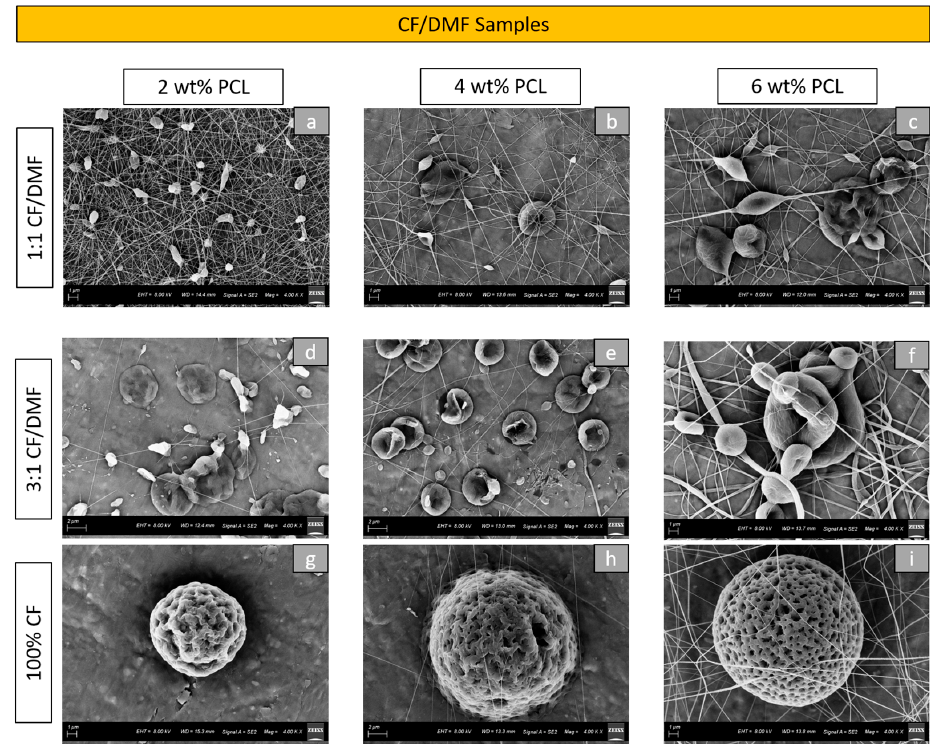
Figure 1. High magnification (4.00 kx) SEM images of PCL particles created by electrospraying: ( a ) 2 wt% PCL with 1:1 CF/DMF; ( b ) 4 wt% PCL with 1:1 CF/DMF; ( c ) 6 wt% PCL with 1:1 CF/DMF; ( d ) 2 wt% PCL with 3:1 CF/DMF; ( e ) 4 wt% PCL with 3:1 CF/DMF; ( f ) 6 wt% PCL with 3:1 CF/DMF; ( g ) 2 wt% PCL with 100% CF; ( h ) 4 wt% PCL with 100% CF; ( i ) 6 wt% PCL with 100%